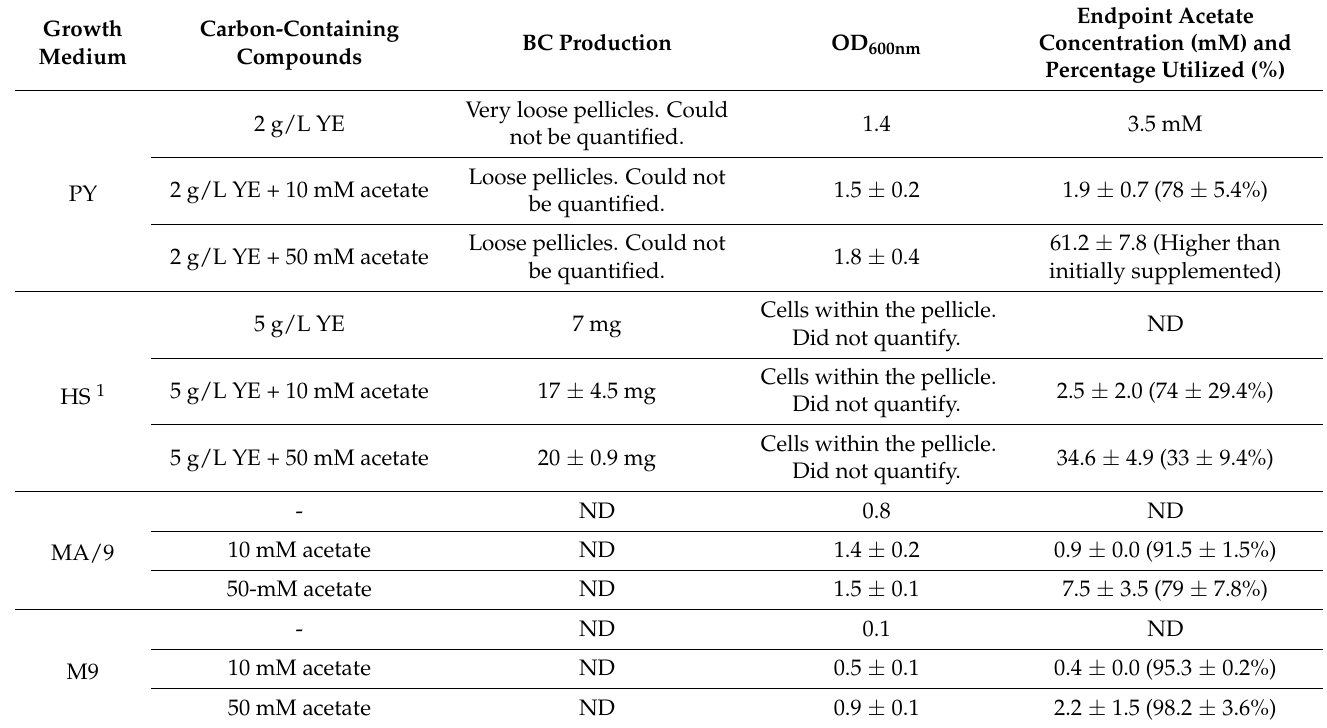
Table 1. Biomass, BC production and acetate utilization from static growth in PY, HS, MA/9 and M9 media containing 10 mM and 50 mM acetate.